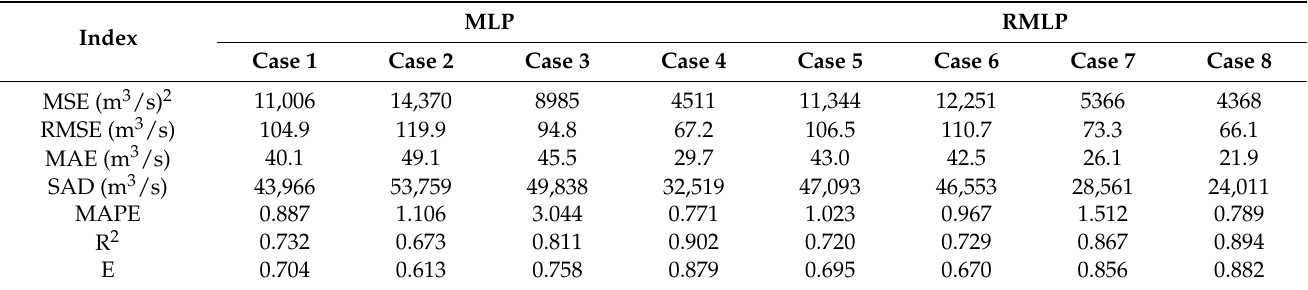
Table 11. Error analyses for all the